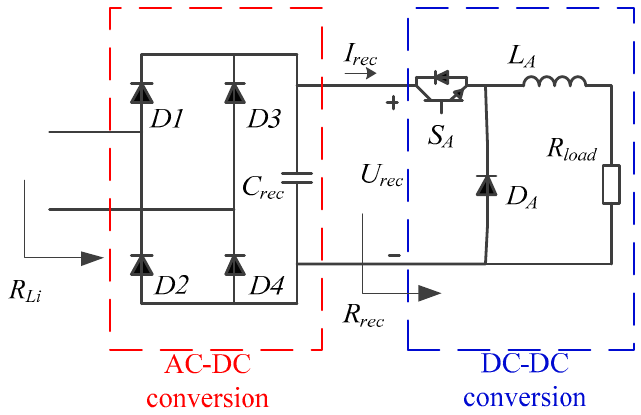
Figure 2. Circuit principle for the equivalent load.